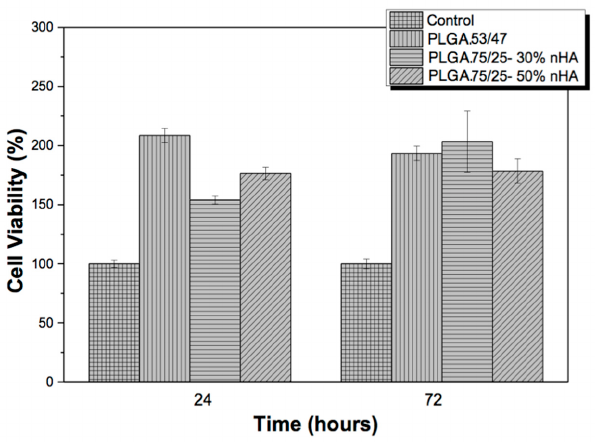
Figure 1. MTT cytotoxicity assays of MC3T3-E1 pre-osteoblast in contact with the as-prepared extraction media exposed to PLGA and PLGA composites with 30 and 50% nHA.